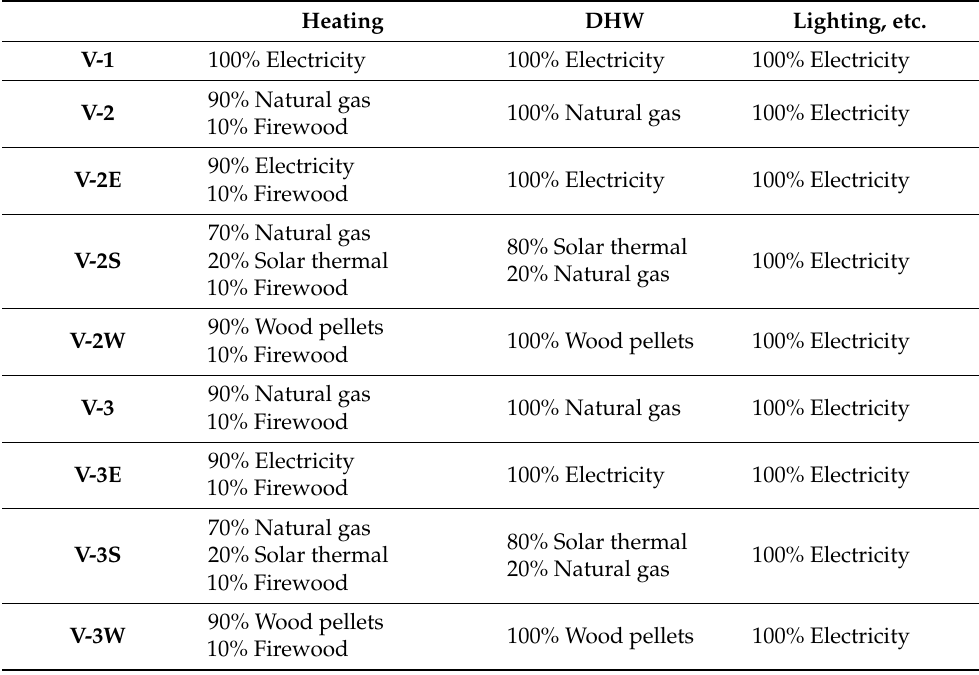
Table 2. Energy sources considered in the